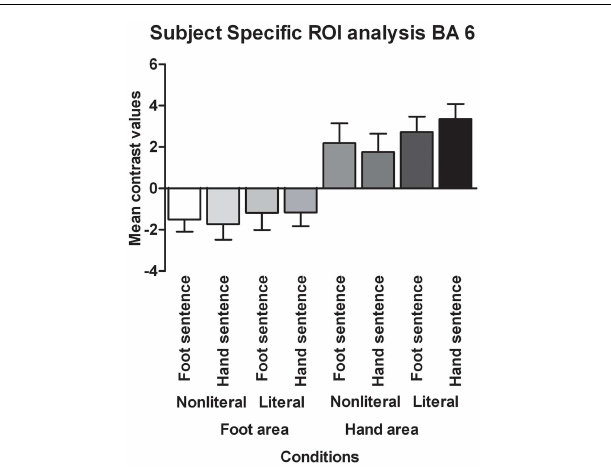
FIGUREA4 |Additional functionally defined, subject-specific ROI analysis for the foot area and hand area in BA 6. The mean contrast values compared to an implicit baseline are shown for each sentence type and extremity.